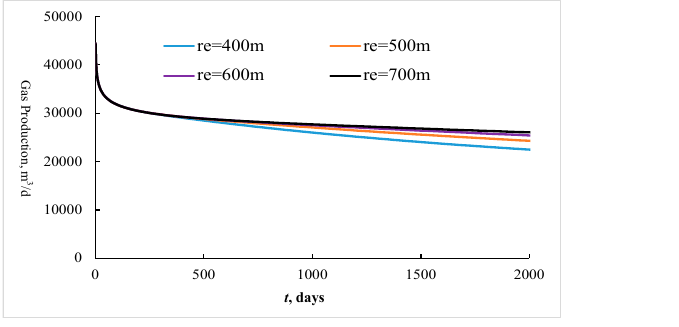
condition of constant bottom hole flowing pressure.